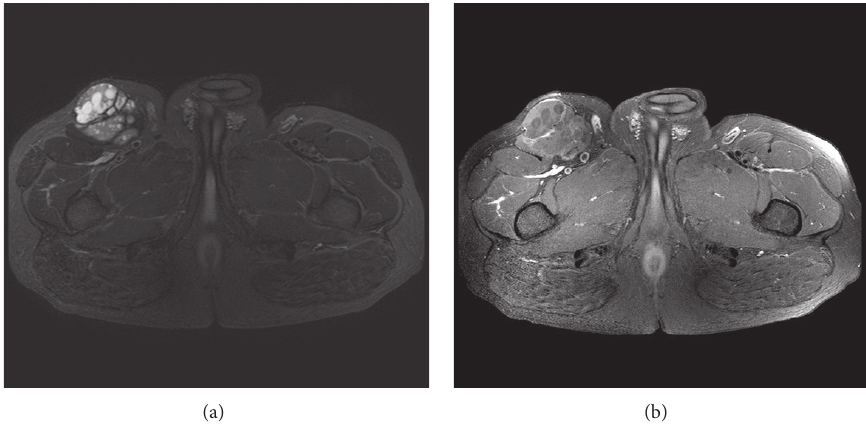
Figure 1: (a) Axial T2 weighed image with fat saturation, it demonstrates a complex cystic lesion arising from the right sartorius muscle. It contains multiple small rounded daughter cysts and internal fibrous septae. No signs of invasion to the adjacent structures to suggest an aggressive sarcoma. (b) Axial T1 weighted image with fat saturation and postcontrast enhanced study: it demonstrates lack of enhancement of the complex lesion. The small rounded daughter cysts are nonenhancing consistent with hydatid cyst. Overall, the lack of enhancement as well as absence of aggressive features favors hydatid disease over soft tissue sarcoma.